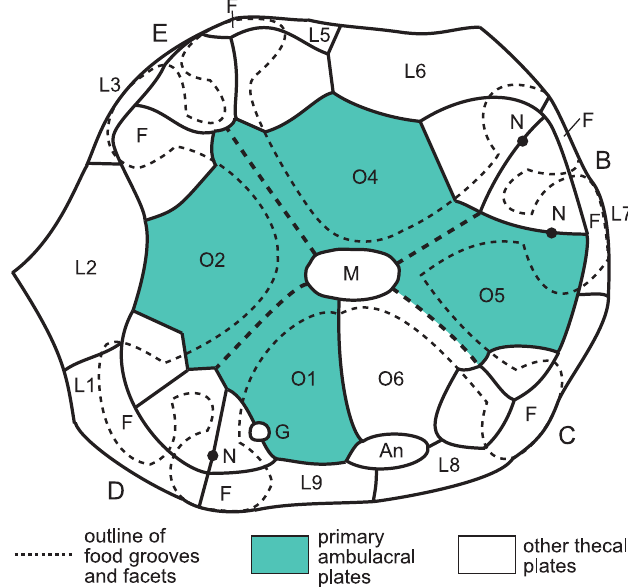
Fig. 22. Oral area of the hemicosmitoid Thomacystis tuberculata Paul, 1969, Late Ordovician, Wales, UK. Ambulacra are interpreted as B, C, D, and E and neither ambulacrum A nor plate O3, the oral associated with ambulacrum A, is developed. Facets (F) are shared by ambulacral plates the homologies of which are uncertain, and lateral plates (L1–L9). Primary ambulacral plates (O1, O2, O4, O5). Plate L4 of hemicosmitids is miss- ing in Thomacystis and caryocrinitids (Paul 1984: 144, fig. 87). An, anus; G, gonopore; M, mouth; N, pore for presumed nerves. Redrawn and rela- belled from Paul 1969: 193, fig.